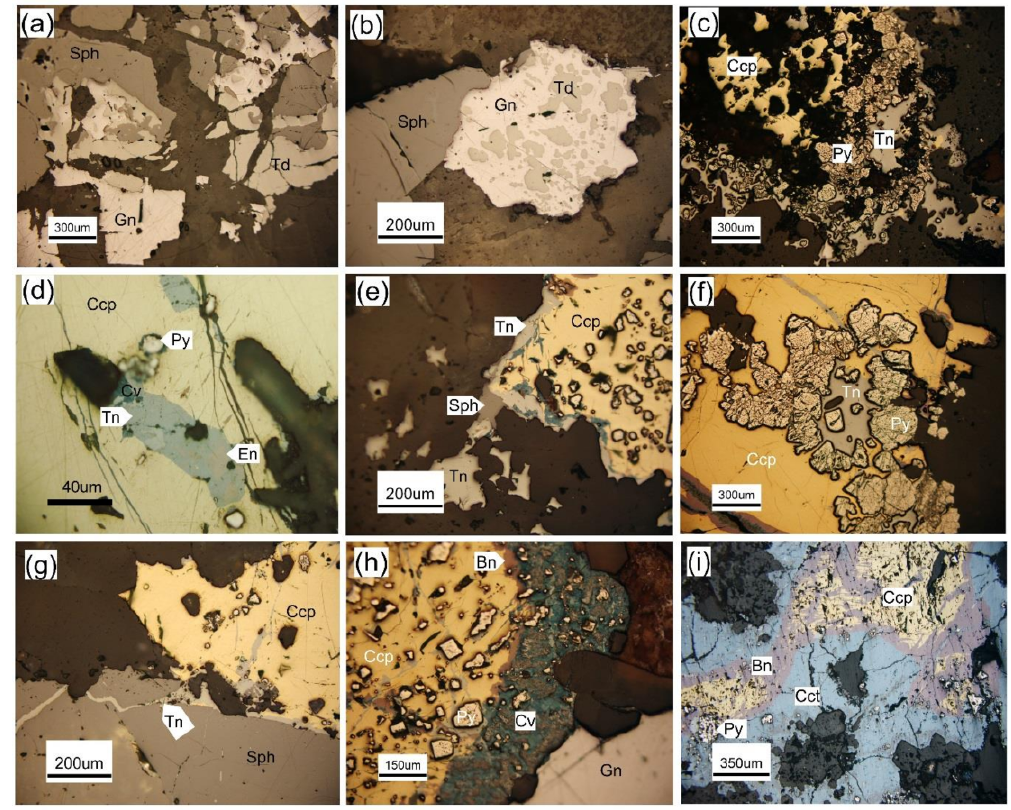
Figure 14. Photomicrographs of reflected-plain polarized light images of sulfosalt minerals and supergene sulfides from Shah-Ali-Beiglou deposit. ( a ) Tetrahedrite (Td) accompanied by sphalerite and galena in Breccia-III; ( b ) Galena is substituted by tetrahedrite in breccia-III; ( c ) Pyrite is substituted by tennantite (Tn); ( d ) Occurrence of enargite (En) as a very minor phase associated with tennantite, within chalcopyrite (Ccp); ( e ) Occurrence of tennantite around chalcopyrite; ( f ) Tennantite infills cavities of the corroded aggregates of anhedral pyrite (Py) grains within chalcopyrite; ( g ) Tennantite infills microfractures in sphalerite; ( h ) Chalcopyrite containing pyrite-II inclusions, is replaced by bornite (Bn) and covellite (Cv) along margins in silica veinlets; ( i ) Chalcopyrite replaces pyrite and both are replaced by bornite and chalcocite